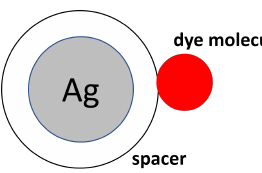
Figure 2. Sketch of a dye molecule attached to a metal nanoparticle (here silver) with a spacer layer to exploit plasmonic enhancement of absorption or